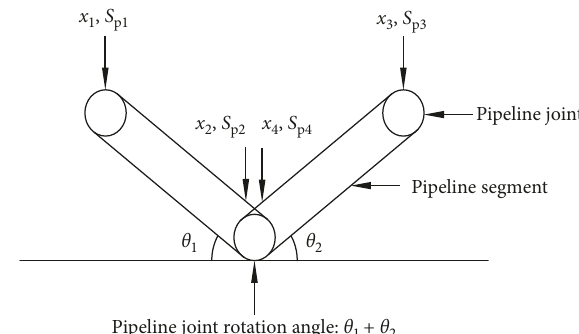
Figure 4: Definition of the joint rotation angle.